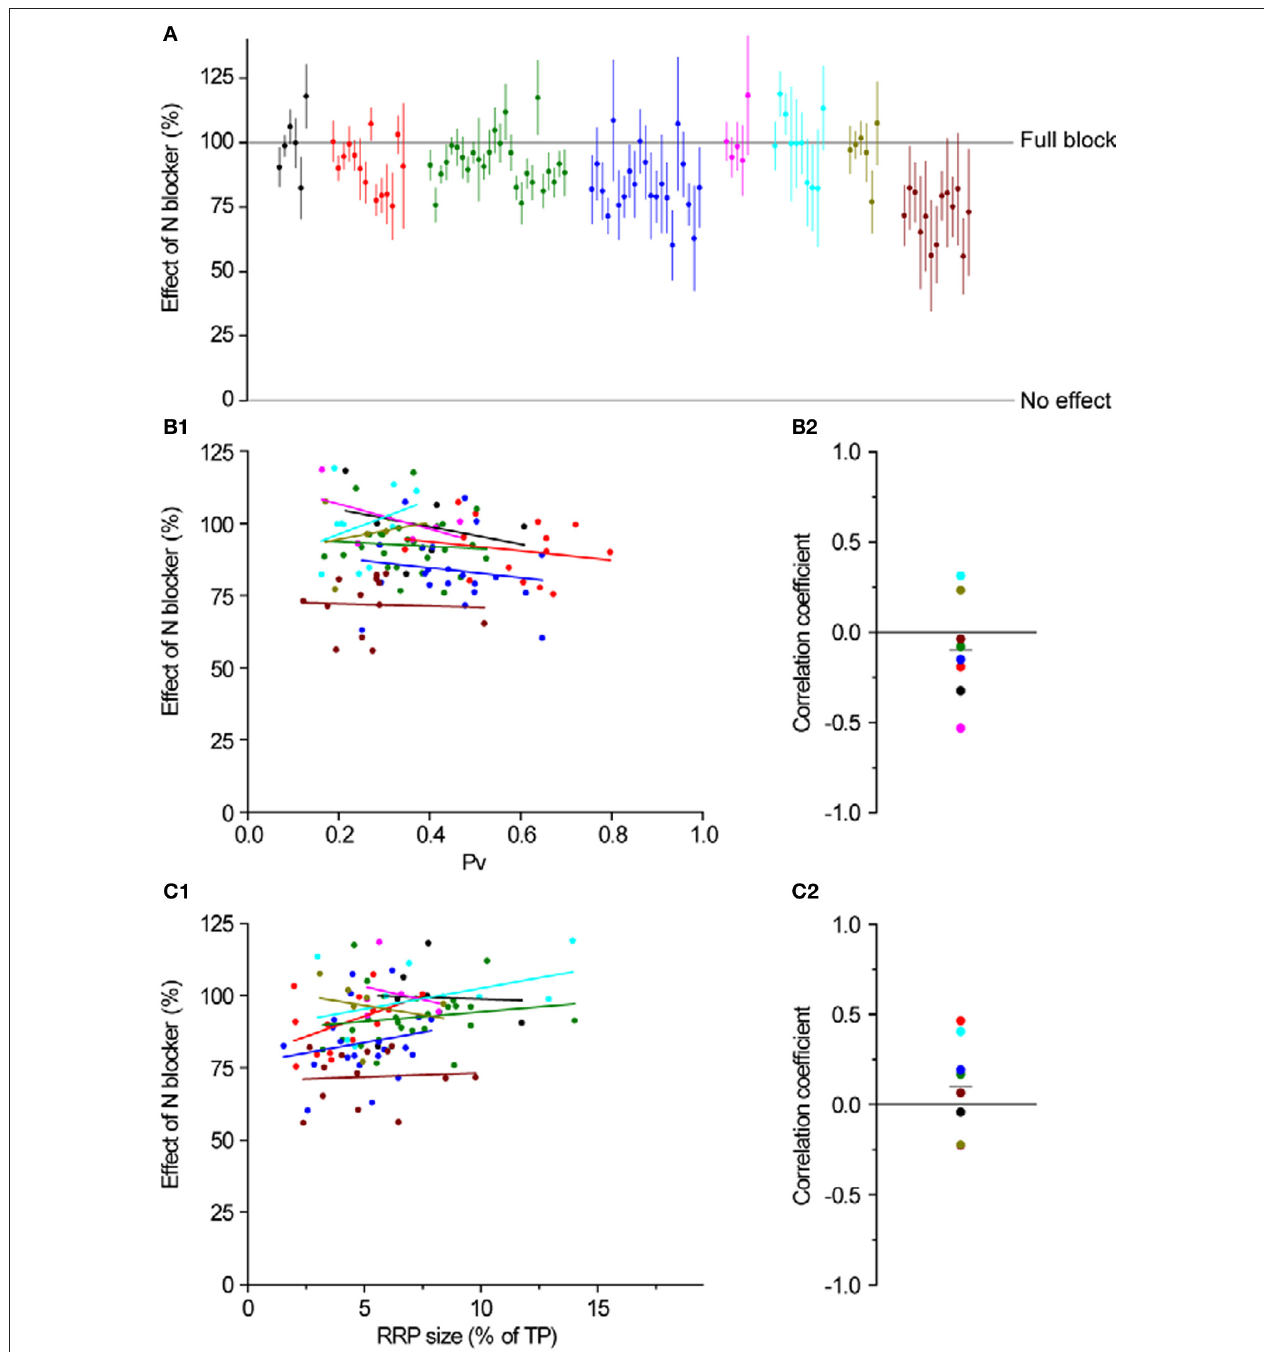
FIGURE 6 | N-type Ca 2 + channel distribution is independent of Pv and RRP size. (A) The effect of ω -conotoxin GVIA on exocytosis in response to a single AP. Different colors represent individual experiments, while each dot shows the effect of the blocker on a single synapse (with its SE). Experiments are ordered according to their responses to an individual AP from highest (left) to lowest (right). Within an experiment, synapses are also sorted from most (left) to least responsive (right). (B1,B2) Effect of an N blocker is independent of Pv . (B1) Each dot is a synapse and the coloring scheme is the same as in (A) . Lines represent best fits for each experiment, colored accordingly. (B2) Correlation coefficients of the effect